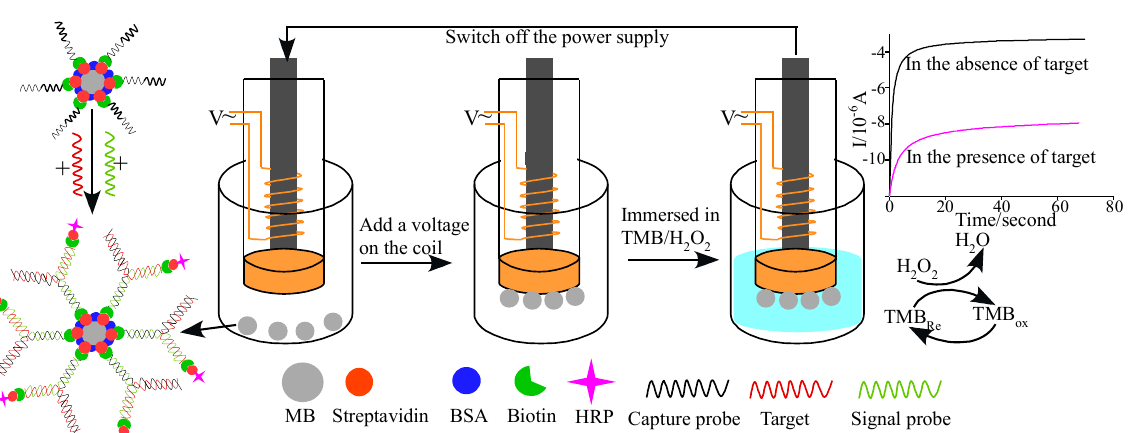
Figure 11. The principle of the magnetic-controllable electrochemical RNA biosensor. Reprinted with permission from [75]. Copyright 2013 Elsevier.